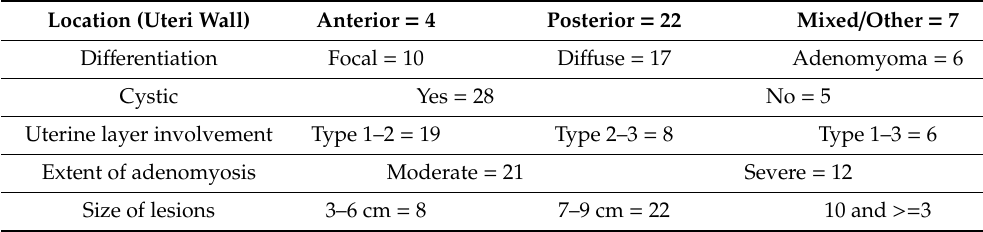
Table 1. Adenomyosis ( AM) group characteristics: TVUS-assessed items.